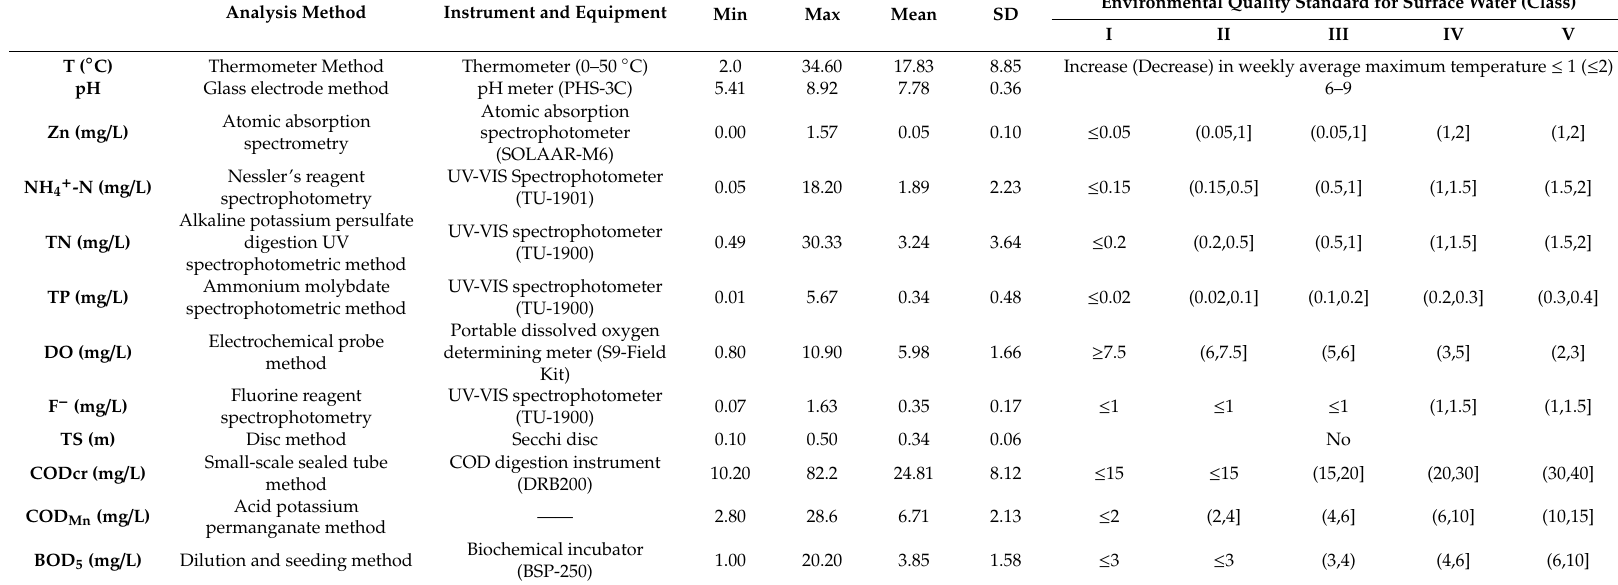
Table 2. Statistical description of water quality indicators and environmental